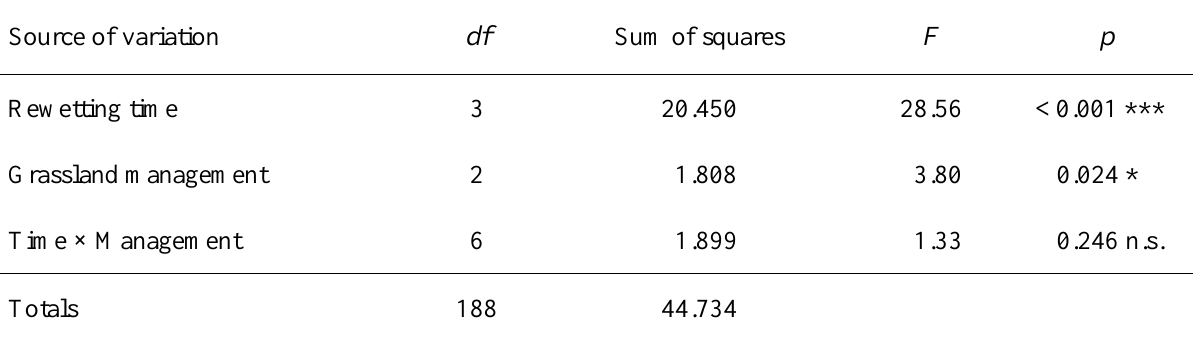
Figure 3. Left (a): the distribution of the highest water levels in 2017 and the nine observation wells (yellow points). Negative values of (increasingly light blue) indicate water levels below the soil surface. Right (b): the distribution of K DL in 2016 and the position of the ten soil profiles (red points). Table 3. K DL content in the topsoil (0–10 cm) after different periods of rewetting (0–17 years) and for different types of grassland management (meadow, mixed use, pasture). The last column indicates significance levels ( p ) for the differences between K DL means: ‘***’ p ≤ 0.001, ‘**’ p ≤ 0.01, ‘*’ p ≤ 0.05; n.s. = not significant ( p > 0.05). df = degrees of freedom, F = F-test